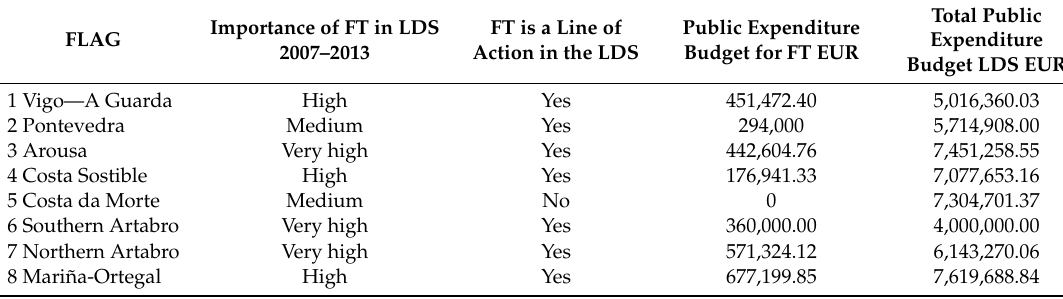
Table 3. Fishing tourism (FT) in local development strategy (LDS) by FLAGs (2014–2020). Importance of FT in LDS FT is a Line of Public Expenditure FLAG 2007–2013 Action in the LDS Budget for FT